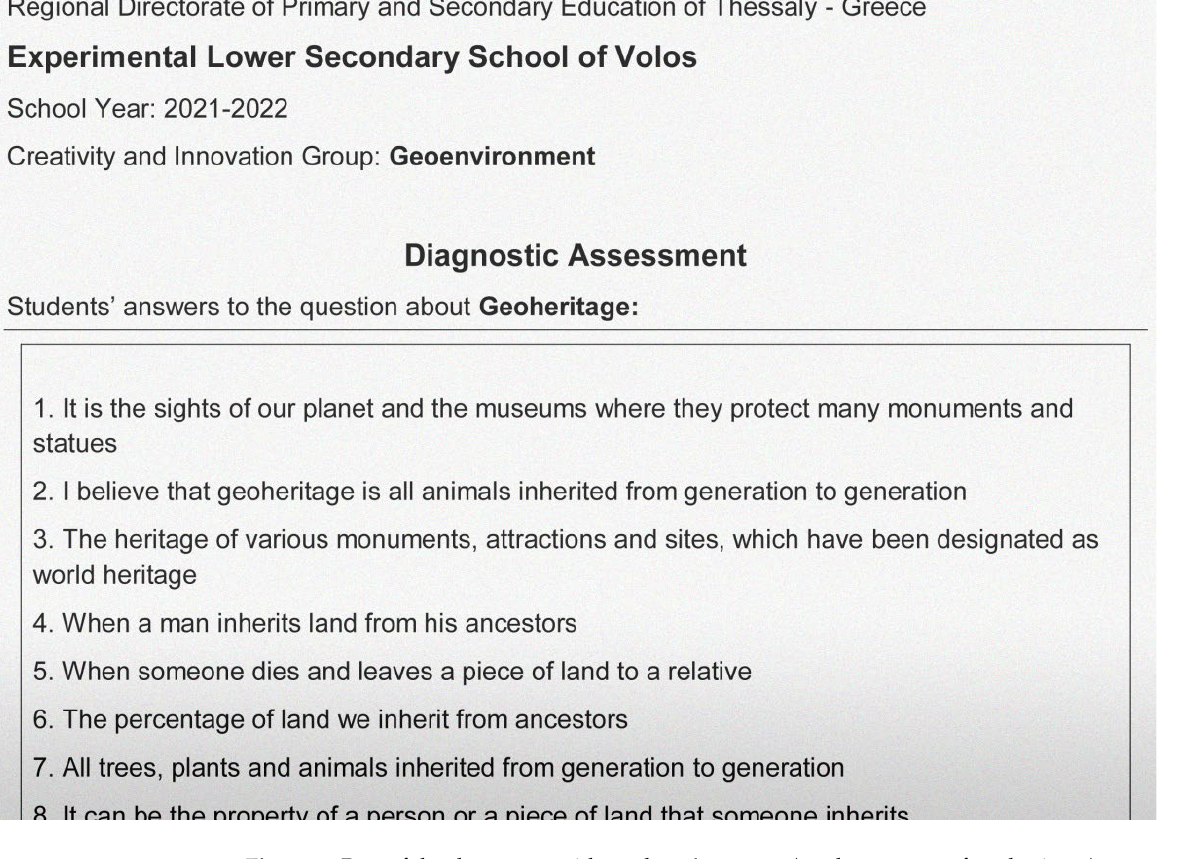
Figure 2. Part of the document with students’ answers (on the concept of geoheritage).